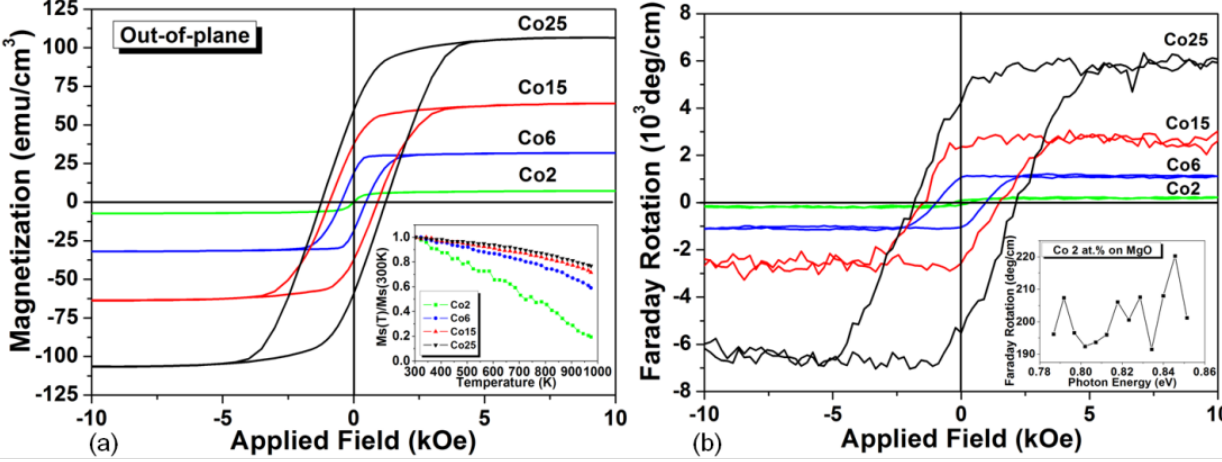
Figure 2. ( a ) Room temperature out-of-plane magnetic hysteresis of Co-substituted CeO 2−δ films, with Co2, Co6, Co15 and Co25 standing for 2 atom %, 6 atom %, 15 atom % and 25 atom % Co substituted CeO respectively. The inset shows the temperature 2−δ dependence of saturation magnetization ( M ) normalized to M at 300 K; ( b ) Room s s temperature out-of-plane magneto-optical hysteresis of Co doped CeO films. The inset 2−δ shows the saturation magnetization as a function of incident photon energy for the Co2 sample [80]. (Reprinted with permission from [80]. Copyright 2008 AIP Publishing